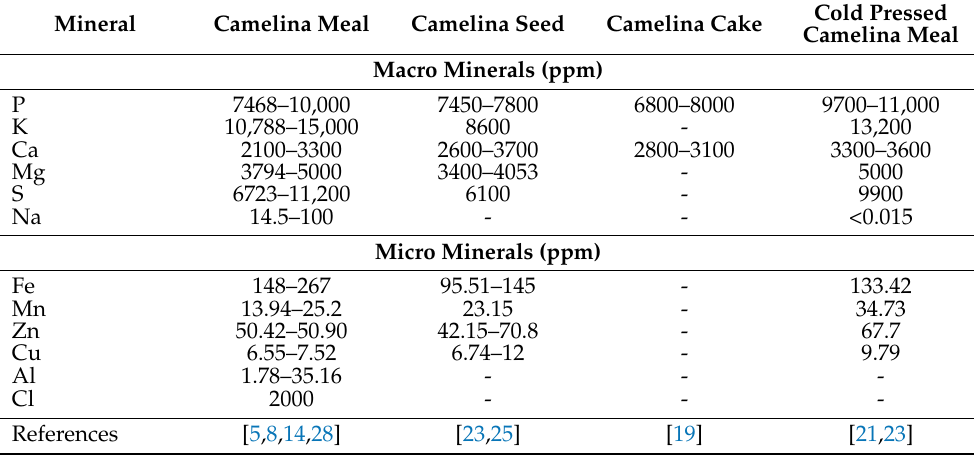
Table 2. Mineral profile of Camelina sativa meal, seed, cake, and cold pressed meal (on DM